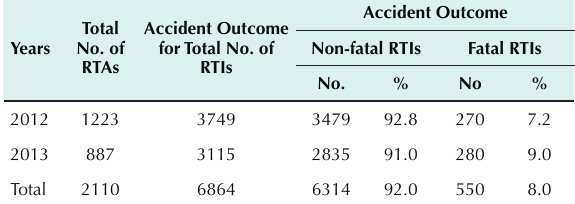
Table 3. Total RTAs and